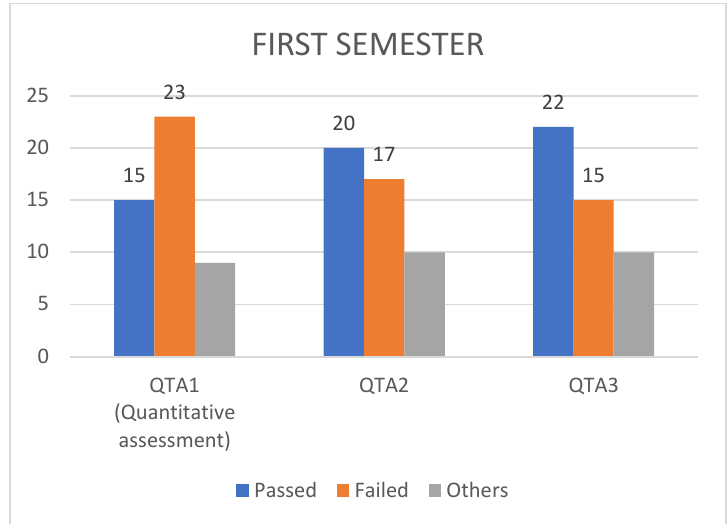
Fig. 2. Number of assessments given in the first semester. Source: Author.